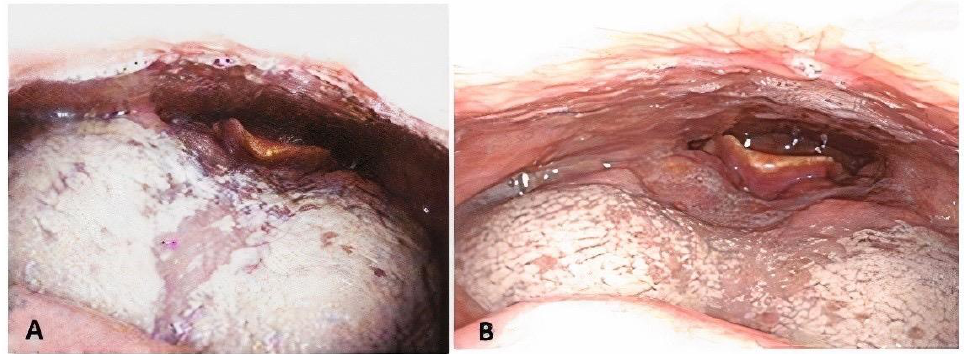
Figure 5. Change of airspace before ( A ) and after ( B ) transoral tongue suspension in fiberoptic na- sopharyngoscopy.